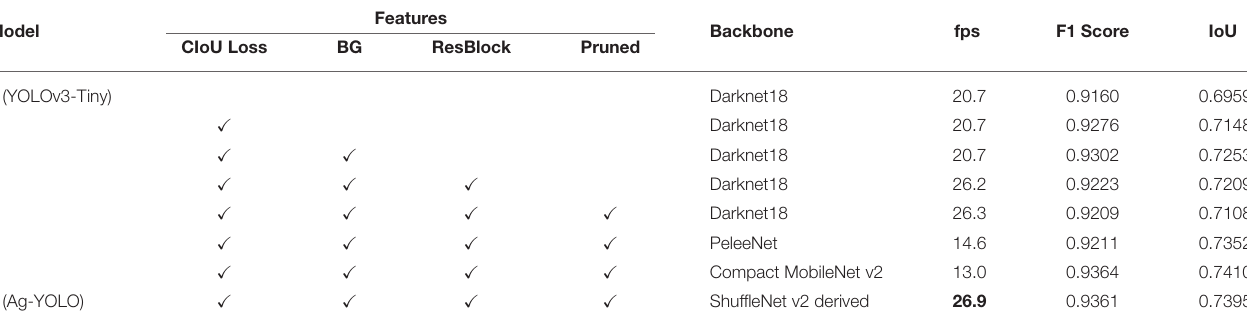
TABLE 8 | Models tested on NCS2.